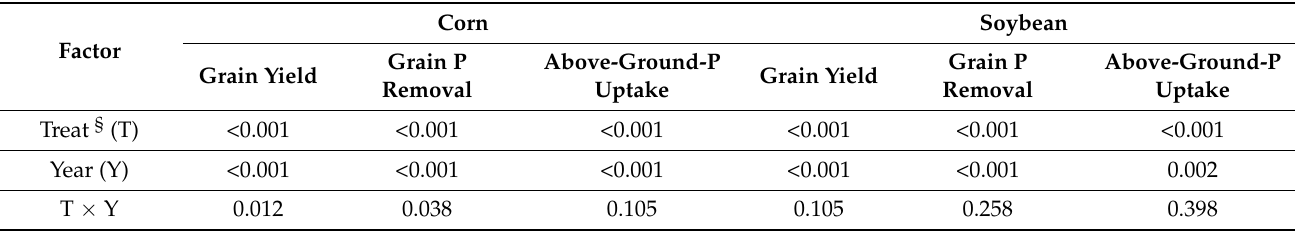
Table 3. Statistical significances of the effects of P application treatment and cropping year on grain yield, grain P removal and above-ground-P uptake (grain and stover) over the 10-year (2004–2013) period in a Brookston clay loam soil, Ontario,